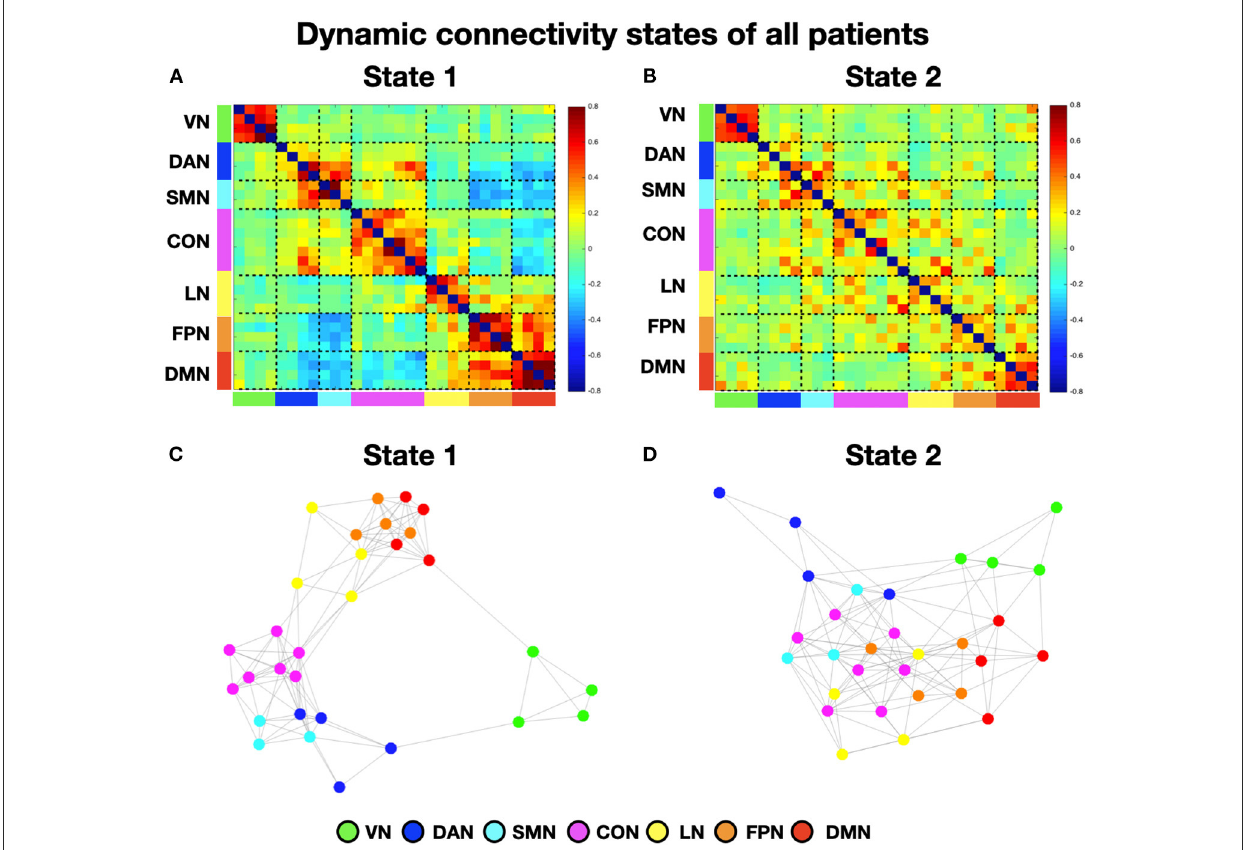
FIGURE1 Dynamic connectivity states of all patients. (A, B) Display the centroid of the functional network connectivity states identified in the whole cohort (i.e., with and without neglect) of patients. The color bar indicates the Fisher-transformed z -scores of the Pearson correlation coefficient ( r ) among fMRI signals between all the possible pairs of nodes. (C, D) Show the spring-embedded representation of the centroid of the functional network connectivity states. VN, visual network; DAN, dorsal attention network; SMN, sensory-motor network; CON, cingulo-opercular network; LN,